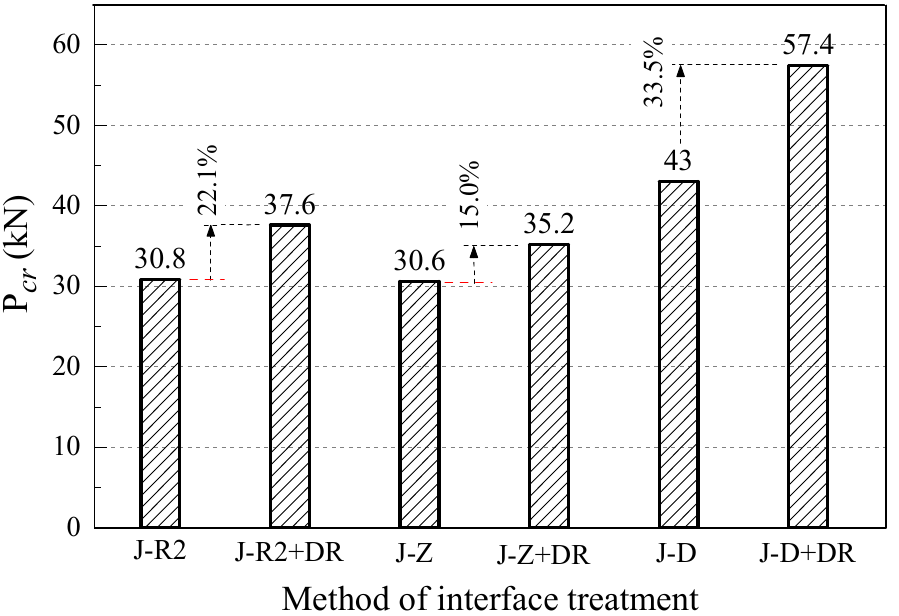
Figure 12. Comparisons of Loads ( P cr ) of first crack at interfaces (DR represents denser